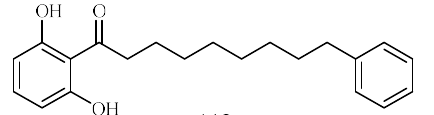
Figure 26. Compound from a Myristicaceae plant.